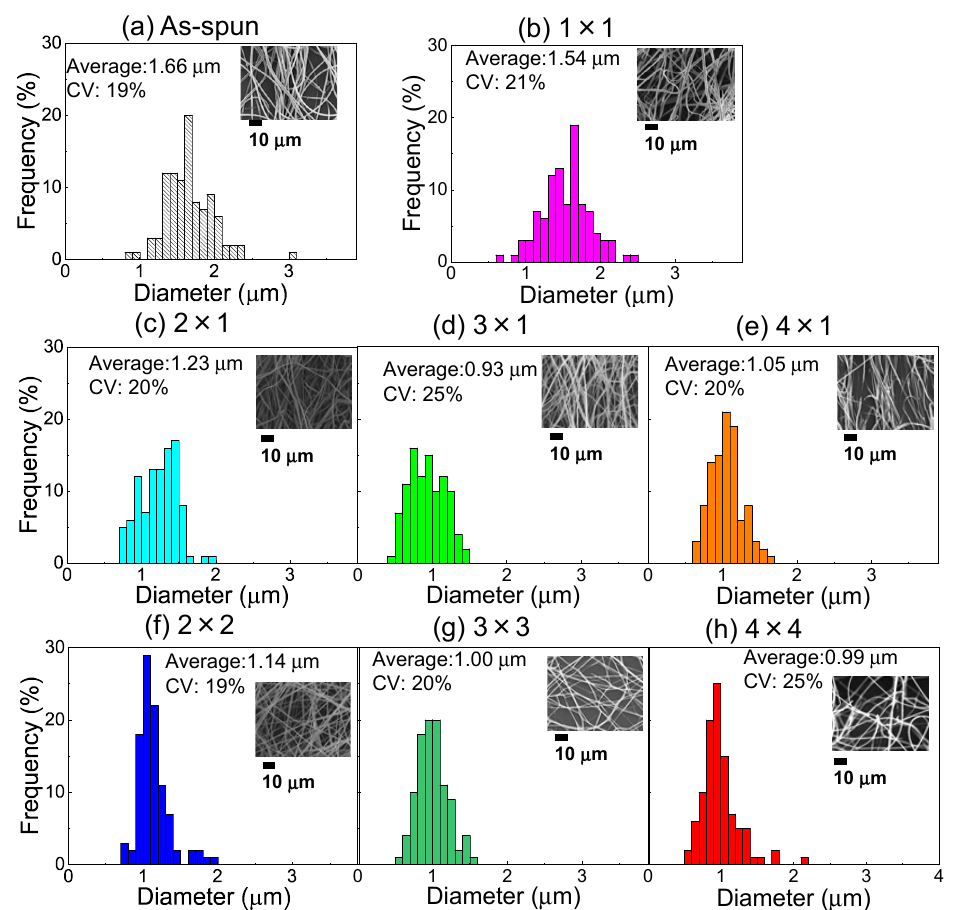
Figure 2. Diameter distribution of fibers in ( a ) the as-spun PET web and ( b ) the web after annealing (MD × TD = 1 × 1). The annealed webs after planar stretching at the stretch ratio of MD × TD = ( c ) 2 × 1, ( d ) 3 × 1, and ( e ) 4 × 1. The annealed webs after simultaneous equibiaxial stretching at the stretch ratio of MD × TD = ( f ) 2 × 2, ( g ) 3 × 3, and ( h ) 4 × 4. Average diameter and its coefficient of variation (CV) as well as the SEM image are shown for each web. Table 1. Diameter and stretch ratio of the fibers in the stretched and annealed webs of various stretch ratios.